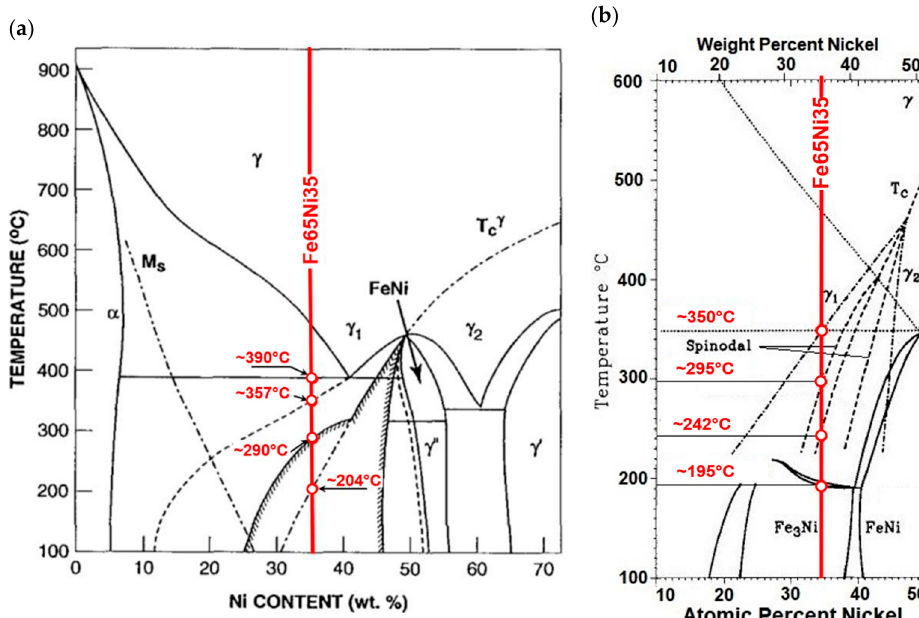
Figure 3. Investigated Fe65Ni35 alloy. ( a ) Fe–Ni phase diagram proposed by Reuter et al. [22,23] and Yang et al. [25], and ( b ) part of the comparison of cluster-variation and spinodal calculations with the equilibrium boundaries proposed by Chuang et al. [21] and Swartzendruber [24].